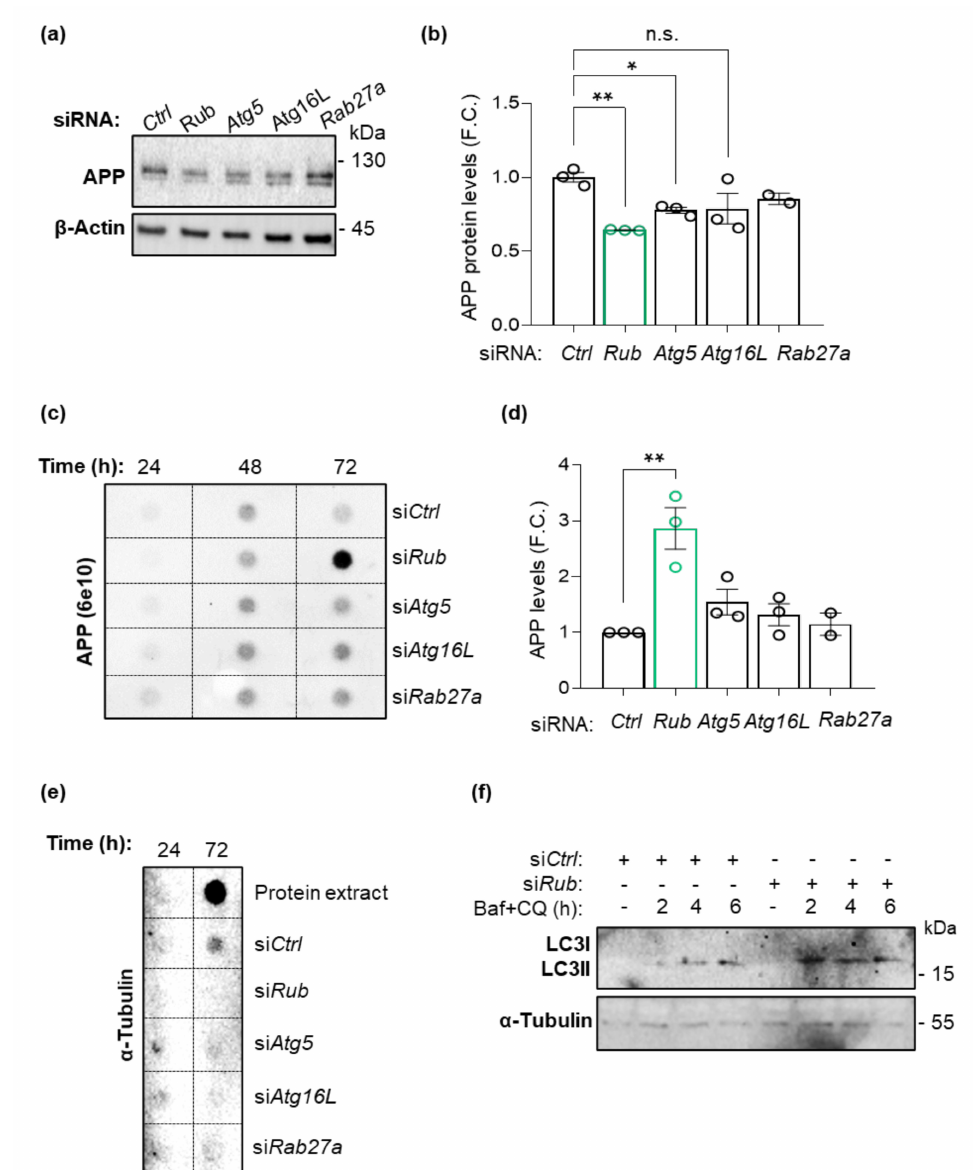
Figure 9. Neuro2A cells expressing human APP-EGFP lacking Rubicon release more APP species to the culture media. ( a ) Neuro2A cells expressing APP-GFP were transfected with siRNA against the autophagy proteins Rubicon (si Rub ), Atg5 (si Atg5 ), and Atg16L (si Atg16L ), an exosomal Rab, Rab27a (si Rab27a ) or control scrambled (si Ctrl ). Protein extracts were analyzed by Western blot using an anti-APP/amyloid β antibody (6E10). ( b ) Densitometric quantification of APP protein levels from protein extracts for each knockdown cell line. β -Actin expression was monitored as a loading control. ( c ) Culture media were collected 24, 48, and 72 h after transfection and analyzed by dot blot using the anti-APP/amyloid β antibody (6E10) and quantified ( d ). FC, fold change. ( e ) PVDF membranes containing culture media from each siRNA cell line plus a control with protein extract in RIPA 1x were incubated with α -Tubulin. ( f ) Autophagy flux in cells si Rub was performed using Bafilomycin A1 (25 nM) and Chloroquine (25 µ M) (Baf + CQ) as lysosome inhibitors for 2, 4, and 6 h before preparing protein extracts. Data are shown as means ± SEM. * p < 0.05; ** p < 0.01 as determined by repeated-measures ANOVA, n.s., no